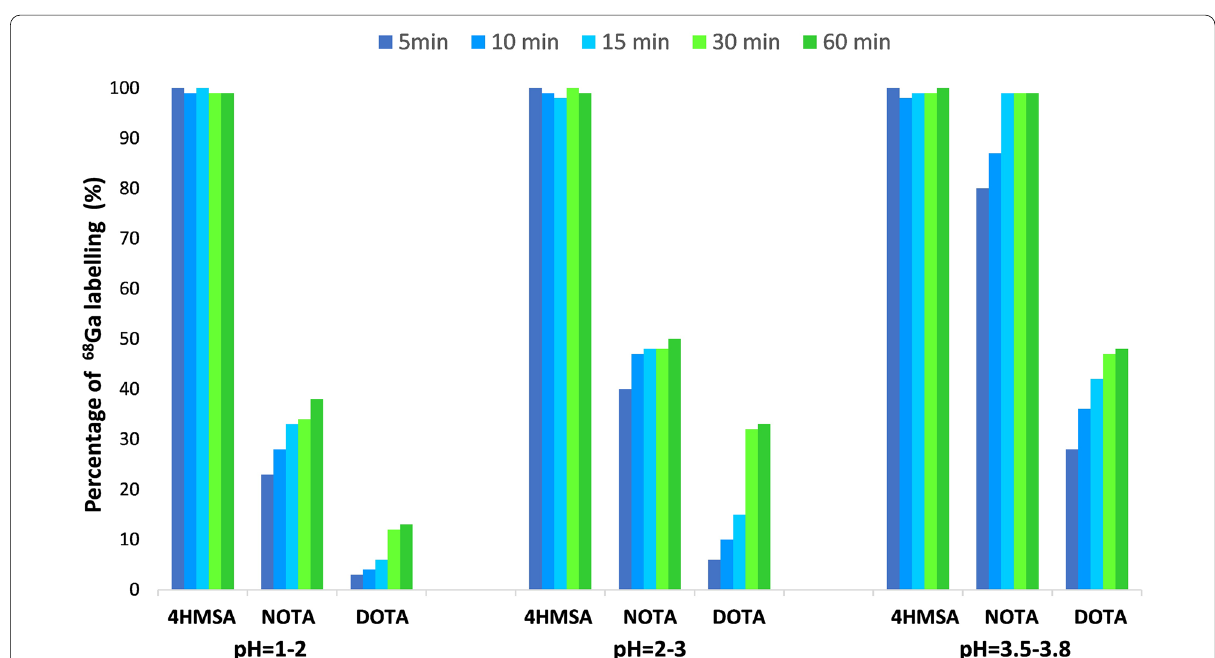
Fig. 5 RCY of 68 Ga with 4HMSA DOTA, NOTA under different pH conditions and as a function of time. The labeling were achieved at room temperature for 4HSMA and NOTA but at 80 °C for DOTA